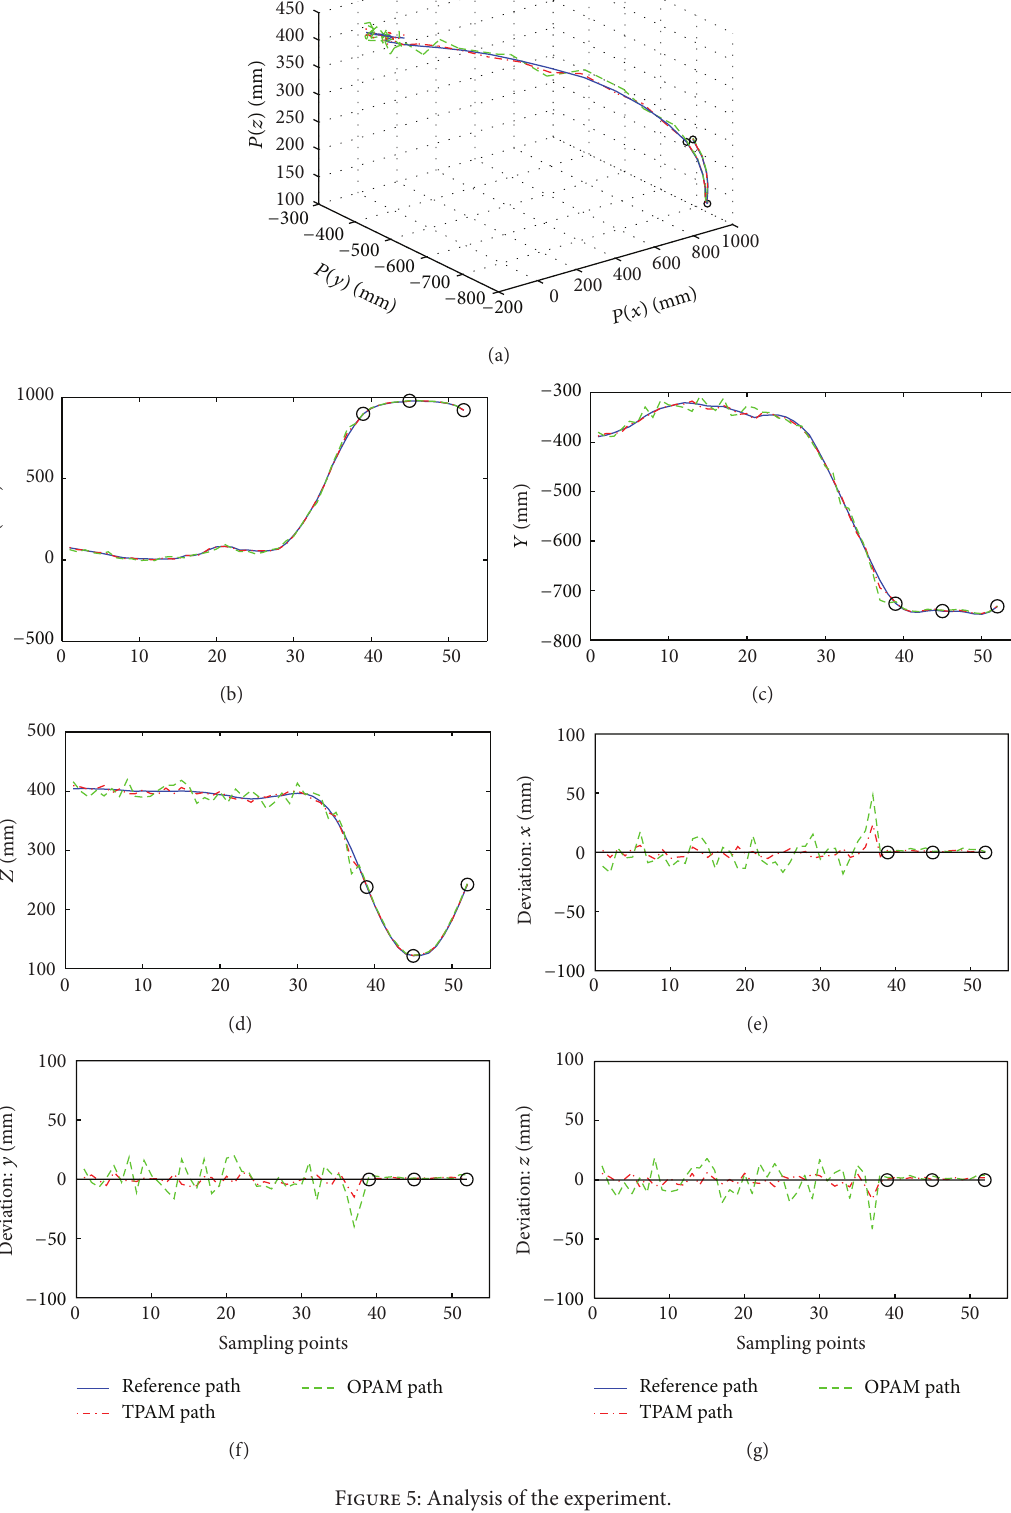
Figure 5: Analysis of the